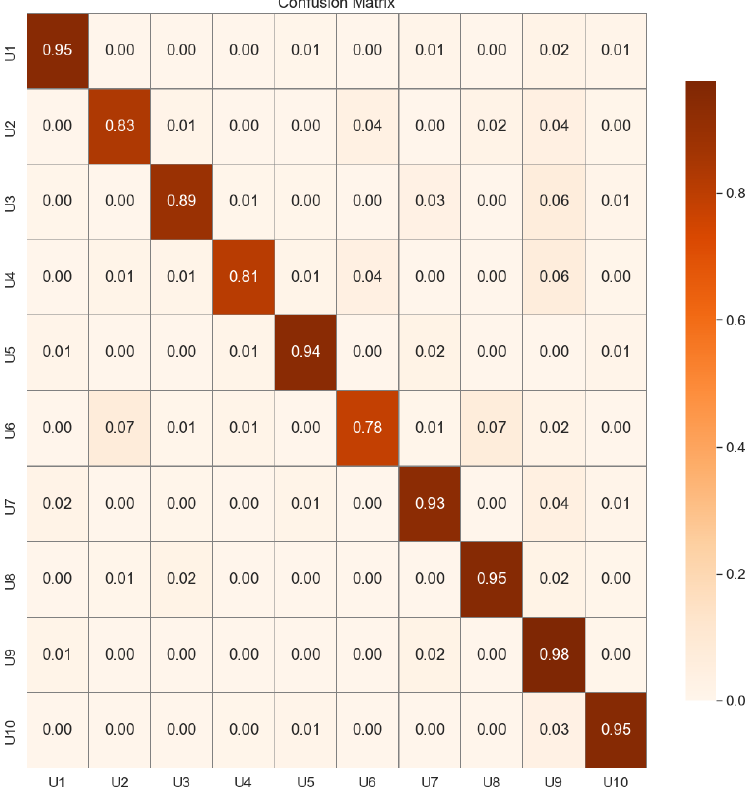
Figure 6. Confusion matrix: validation test. Table 1. Accuracy of the